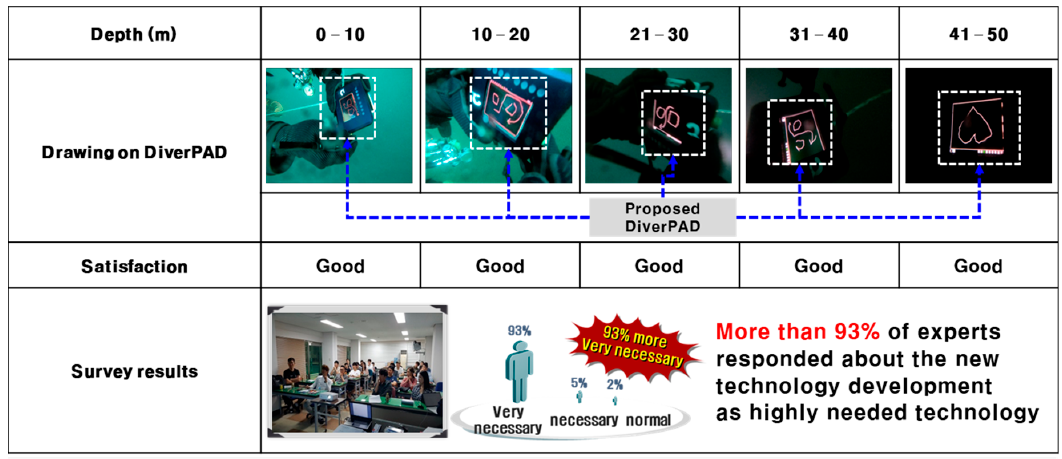
Figure 12. Drawing tests on DiverPAD.